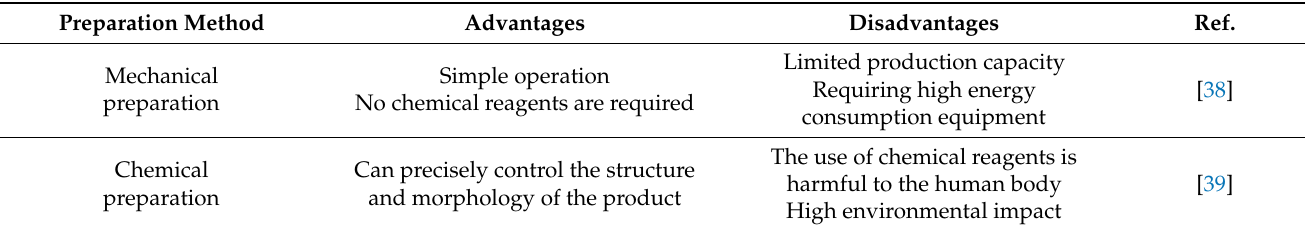
Table 2. Classification of nanocellulose preparation